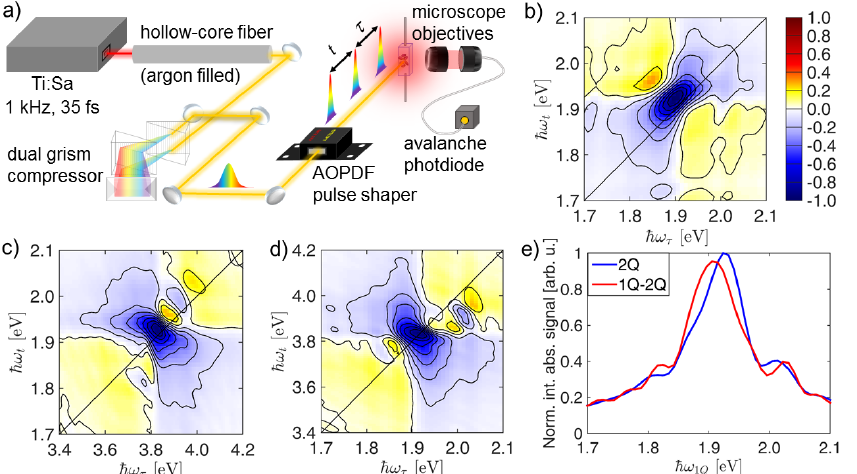
Fig. 2. Setup and experimental results. (a) An acousto-optic pulse shaper generates phase-coherent pulse sequences on a 1 kHz shot-to-shot basis. We recover, from a single raw data set, the (b) 1Q photon echo, (c) 2Q, and (d) 1Q-2Q 2D spectra of Rhodamine 700 in ethanol. Five-fold zero padding was applied, and all plots are normalized to their highest absolute value. (e) Projections of the 2Q and 1Q-2Q spectra onto the 1Q axes (normalized to the highest absolute value of the 2Q projection). Both 2Q-associated spectra [(c) and (d)] look very similar. However, by analyzing the absolute-valued projections onto their respective 1Q axes [Fig. 2(e)], it is evident that the | e   | f  transition manifests as a blueshift of the 2Q lineshape. This indicates a low value